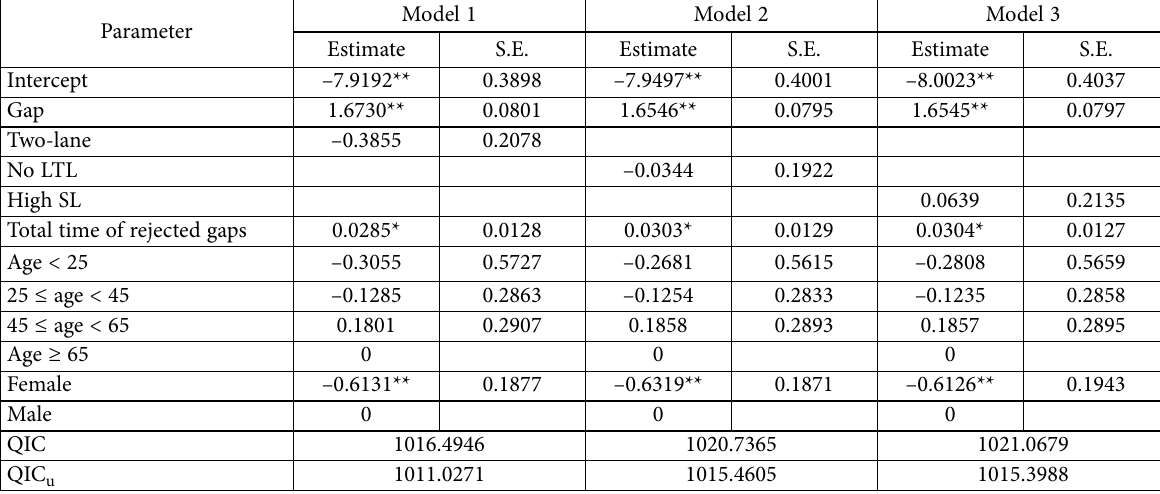
Table 5. Parameter estimates of the models on total time interval of rejected gaps